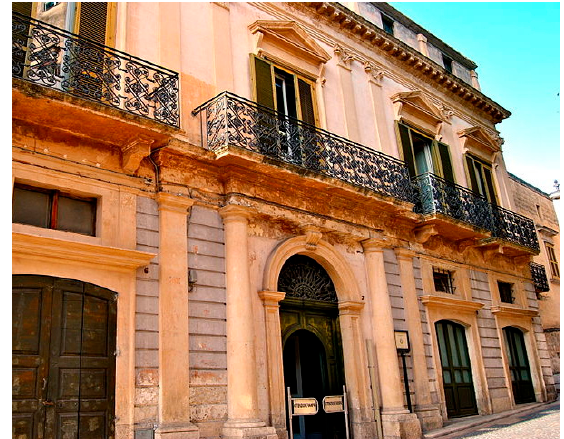
Energies 2017 , 10 , 2009